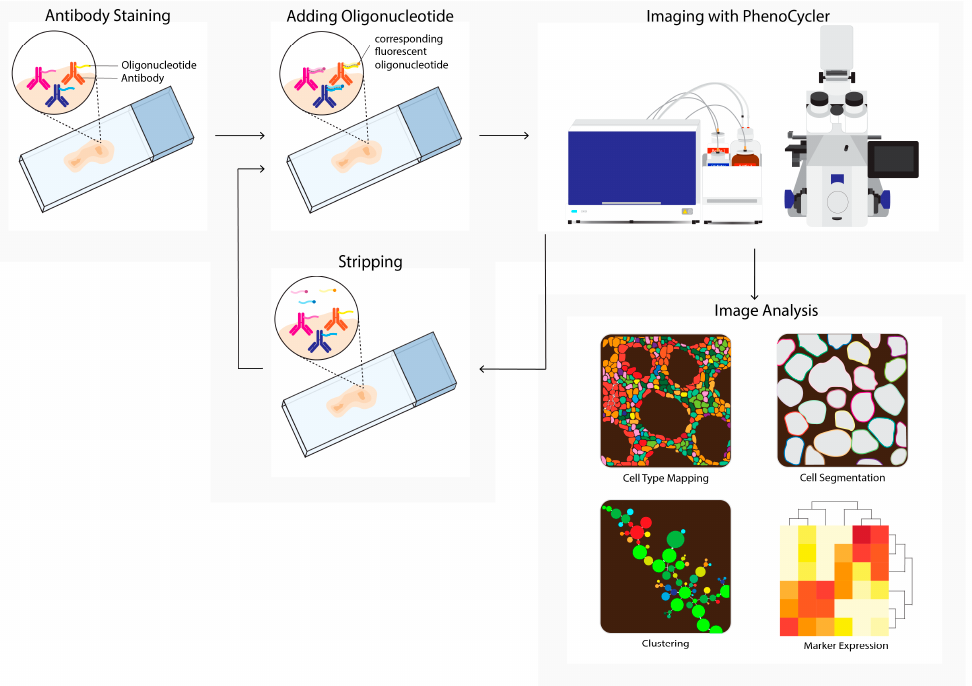
Figure 3. PhenoCycler (CODEX) workflow. Tissue is labeled using oligonucleotide-conjugated antibodies to detect up to one hundred markers simultaneously. Initial antibody staining is followed by hybridization cycles with three reporter oligonucleotides containing spectrum-separable fluo- rophores, which hybridize with the unique antisense oligonucleotide conjugated to the primary antibody (left). After each cycle, a microscopy image is acquired (imaging with PhenoCycler). Next, reporters are removed; this is followed by the next reporter hybridization cycle. Images from all cycles are compiled and registered to generate multiplex data images. During imaging analysis, these images can be processed into single-cell expression data and downstream analysis is performed (e.g., cell type mapping, clustering, marker